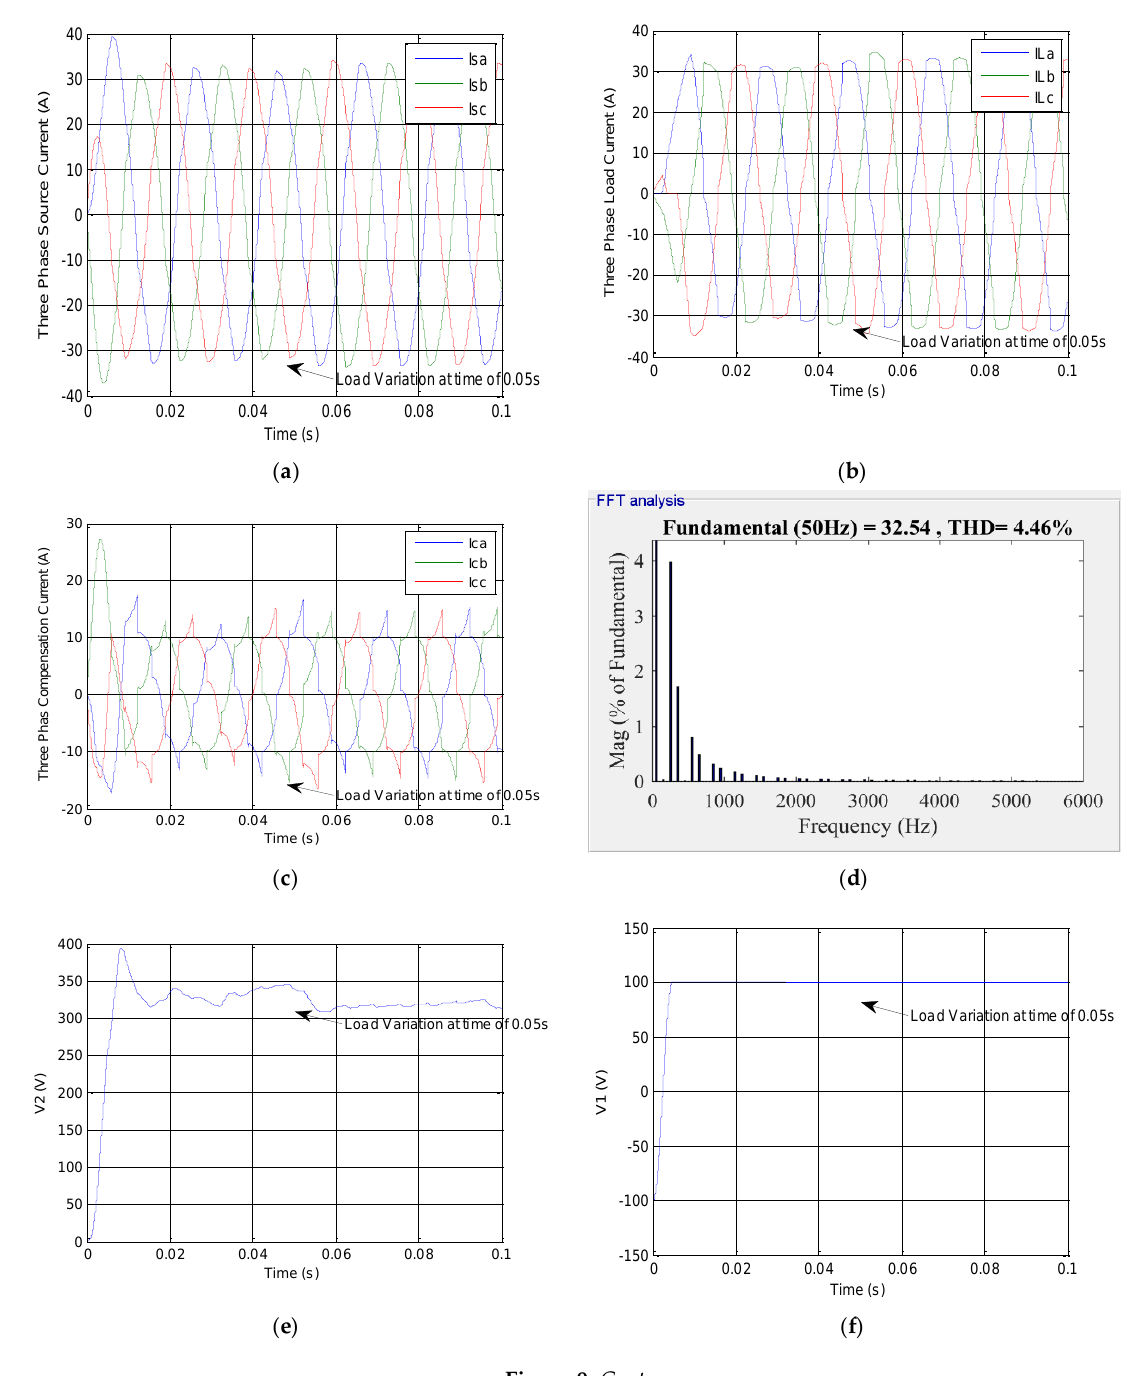
Figure 9a–c shows the change in source current, load current and compensation current for the RL load when the SAPF was connected. When the proposed system was subjected to load changes of the diode rectifier bridge, the DC link voltage profile had a peak overshoot with a voltage of 387 V before it settled at a time of 0.13 s and reached a voltage of 327 V with zero steady state error as shown in Figure 9e. At 0.05 s, the load was increased by 5 Ω and it was observed that the controller had null overshoots, zero steady state error, and zero settling time. Figure 9g shows the three-phase line voltage of the three-phase split source inverter with 315 V. Figure 9h shows the source current profile in phase with the source voltage. The source current reached almost near to its current profile with a harmonic percentage of 4.46%, which is shown in Figure 9d.